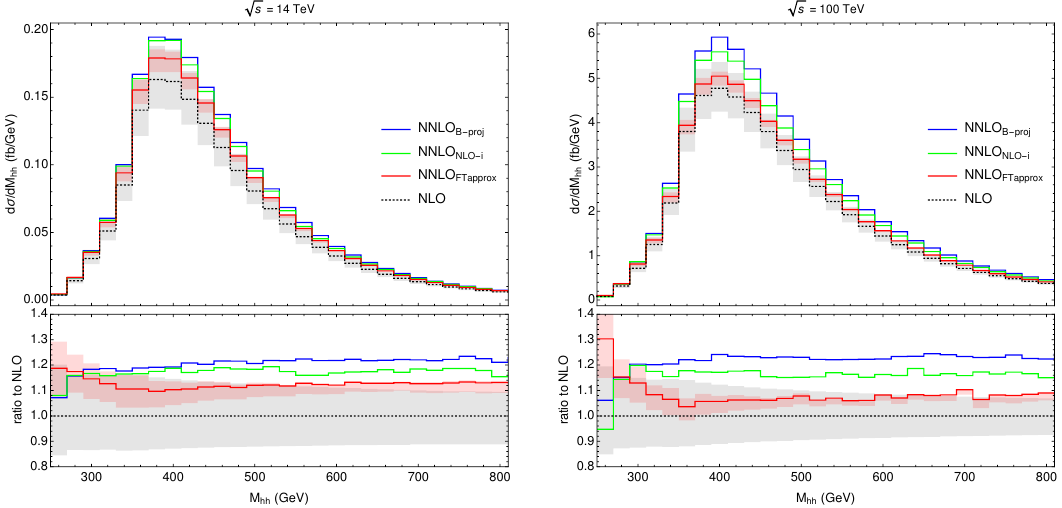
Figure 2 . Higgs boson pair invariant mass distribution at NNLO for the di(cid:11)erent approximations, together with the NLO prediction, at 14 TeV (left) and 100 TeV (right). The lower panels show the ratio with respect to the NLO prediction, and the (cid:12)lled areas indicate the NLO and NNLO FTapprox scale